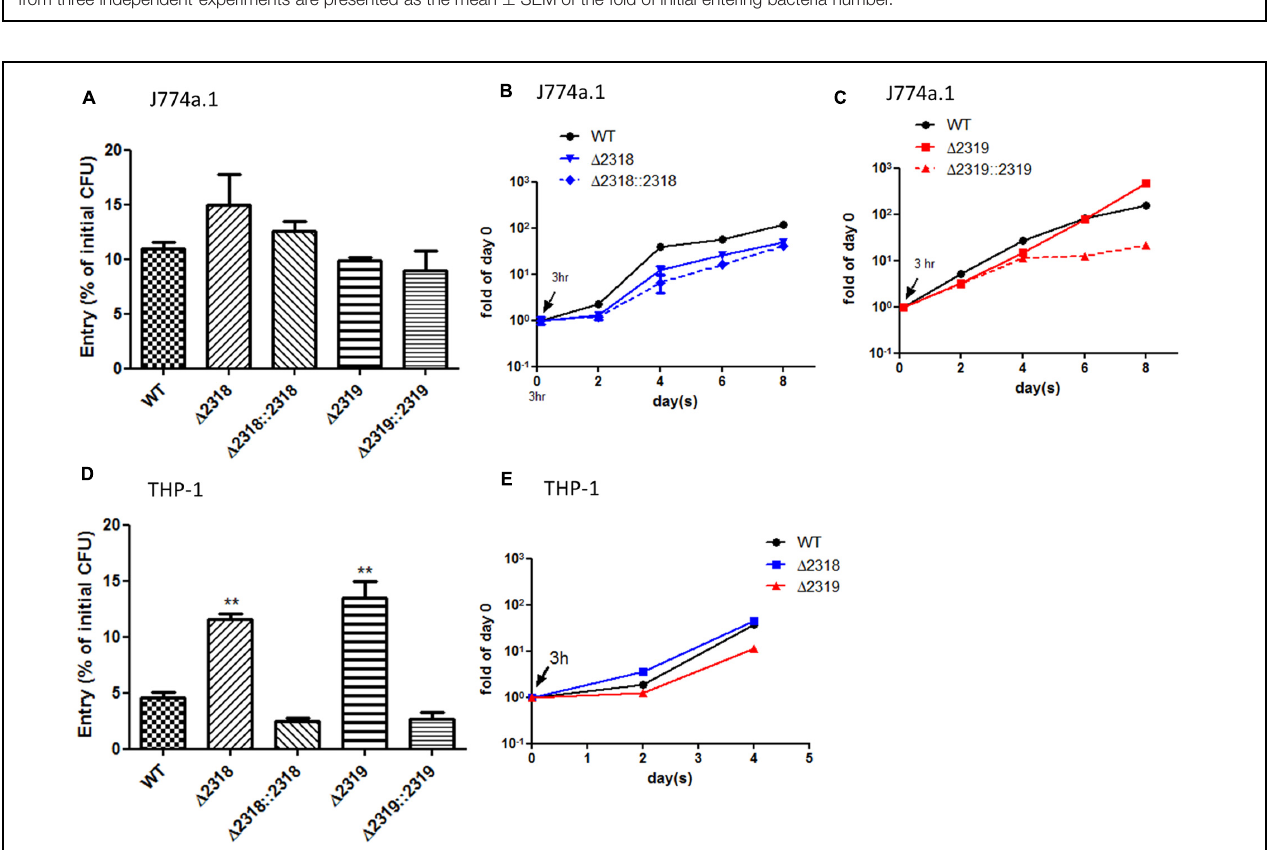
FIGURE 6 | Entry and growth of M. marinum inside macrophages. The entry of M. marinum wild-type, (cid:2) 2318 , (cid:2) 2319 , (cid:2) 2318 :: 2318 , and (cid:2) 2319 :: 2319 strains into macrophages. The bacteria numbers inside macrophage cells on day 0 (3 h post infection) at MOI = 10 were determined. Entry was represented as the percentage of entry CFU vs. initial CFU of three independent experiments. No significant differences were noted among the wild-type strain, the deletion mutants ( (cid:2) 2318 and (cid:2) 2319 ), and the complementation strains ( (cid:2) 2318 :: 2318 and (cid:2) 2319 :: 2319 ) into J774a.1 (A) but the recovered bacteria number of two deletion mutants were significantly higher than wild-type strain into THP-1 (D) . Data from three independent experiments are presented as the mean ± SEM of the % of initial CFU. ∗∗ p < 0.001. Growth kinetics of the M. marinum wild-type, (cid:2) 2318 , (cid:2) 2319 , (cid:2) 2318 :: 2318 , and (cid:2) 2319 :: 2319 strain inside macrophages. The bacteria numbers inside J774a.1 (B,C) or THP-1 (E) cells on days 0 (3 h), 2, 4, 6, and 8 days at MOI = 1 were determined. Data from three independent experiments are presented as the mean ± SEM of the fold of initial entering bacteria